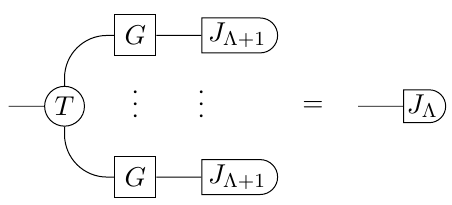
Figure 13. Renormalization of a deformation of a p -adic